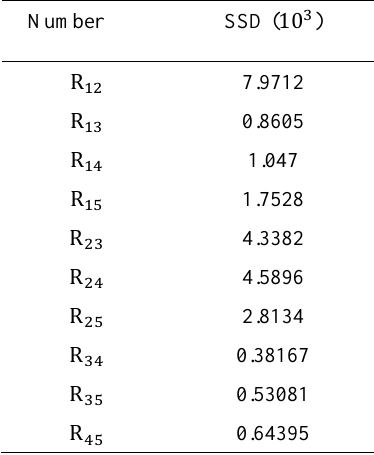
Table 1 Related parameters SSD of arbitrary two images in PMMW sequence